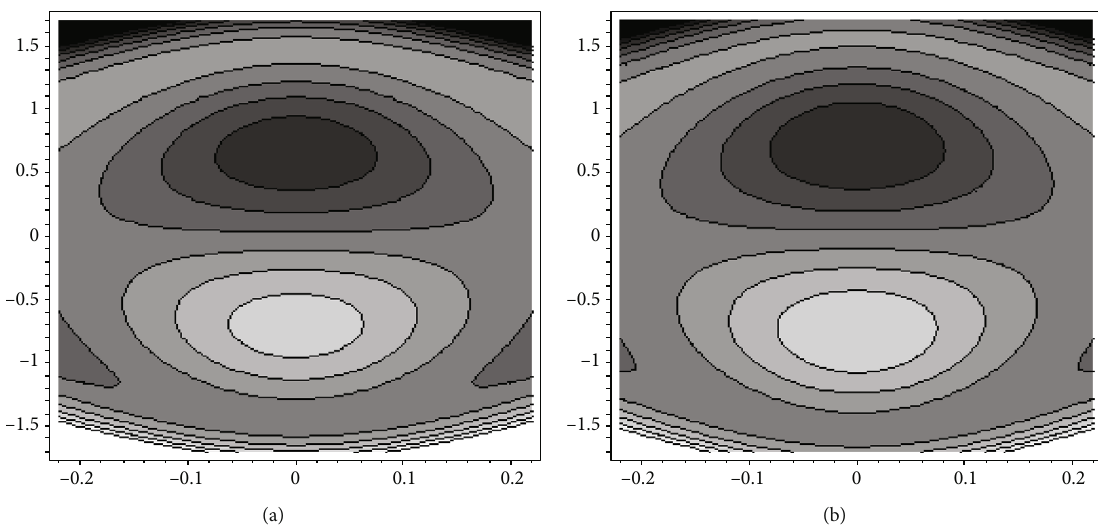
Figure 22: Stream lines for di ff erent values of φ . The other parameters are n = − 0 : 8 , β = 7 , We = 0 : 6 , y = 1 , and Q = 2 : 0 .